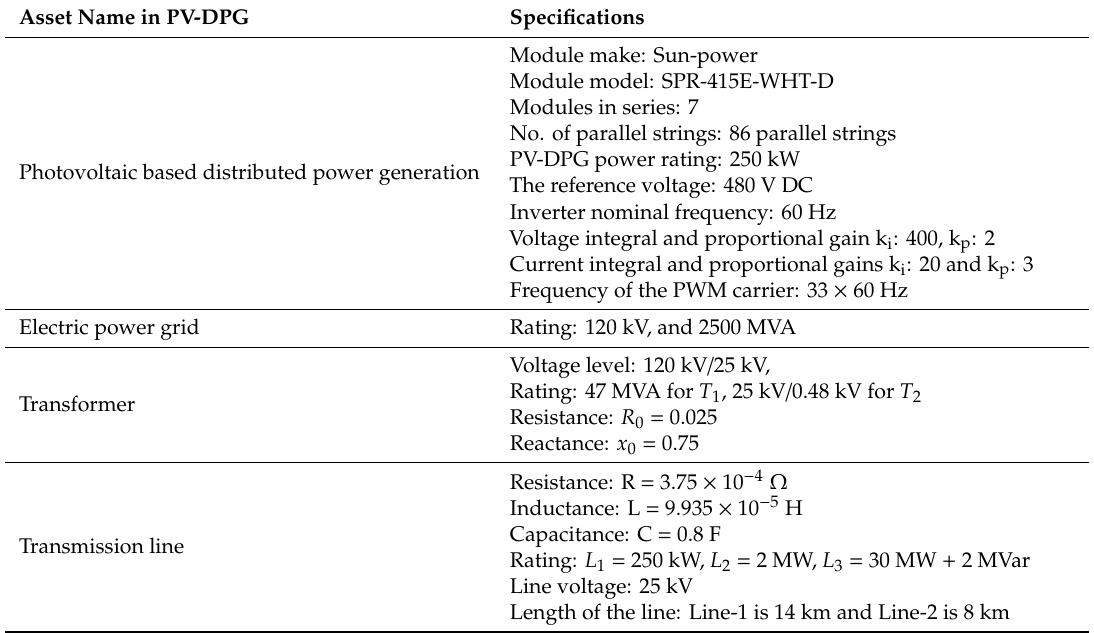
Figure 1. The schematic view of the studied distributed power generation system. The assets of this PV-DPG system are provided in Table 1. Considering all these assets listed in Table 1, the system is modeled, simulated, and then analyzed using MATLAB/Simulink tool 2019a. Table 1. The technical specifications of the studied photovoltaic based distributed power generation (PV-DPG) model [36].